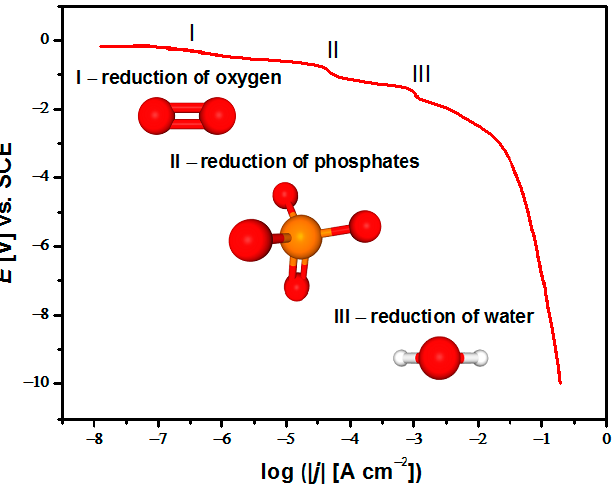
Figure 1. The E = f(log| j |) polarization curve of the ECAD of the CaP coating on the CpTi G4 substrate in the acetate bath in the potential range from E stat to E = − 10 V vs. SCE at room temperature using v = 1 mV s − 1 .